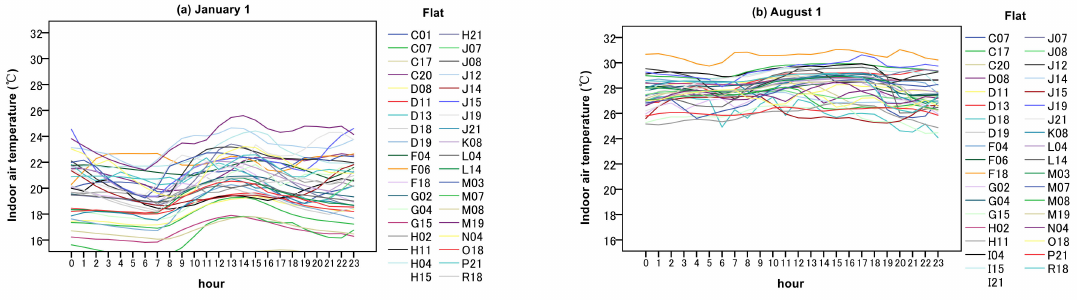
Figure 6. Indoor air temperatures: ( a ) January 1 and ( b ) August